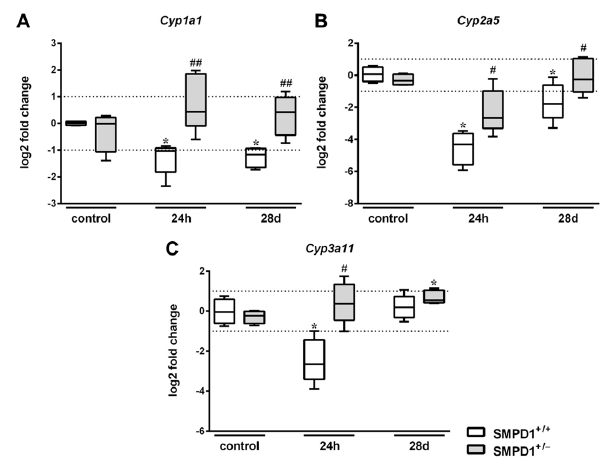
Figure 3. Hepatic cytochrome P450 mRNA expression following polymicrobial sepsis induction . Quantitative real-time PCR of ( A ) Cyp1a1 , ( B ) Cyp2a5 , ( C ) Cyp3a11 was performed in liver tissue